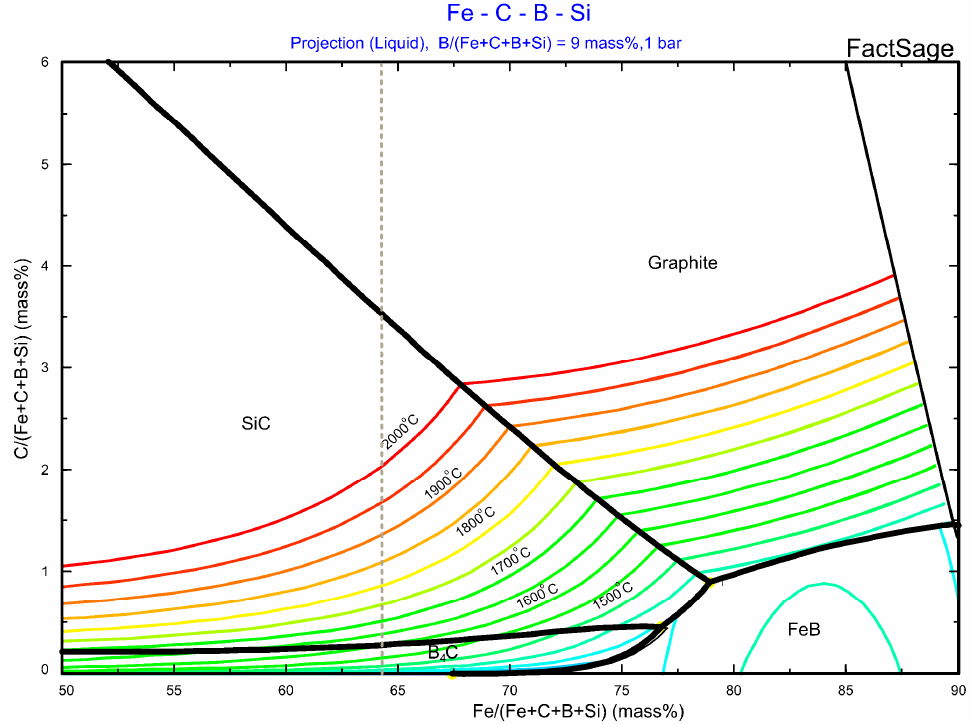
Figure 13. Liquidus projection of Fe-Si-9mass %B-C phase diagram.